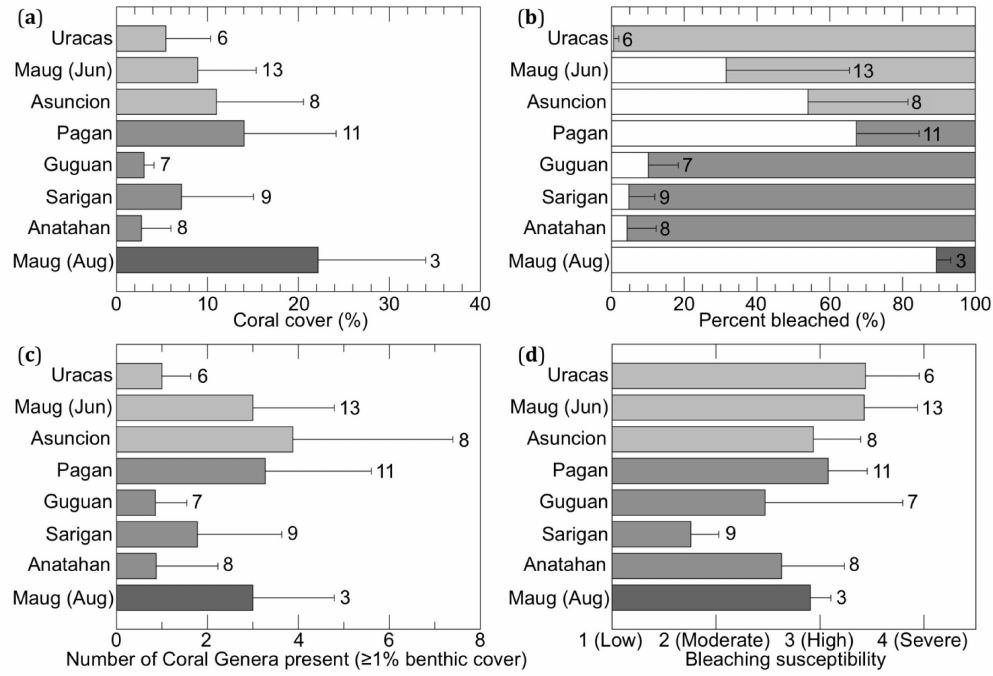
Figure 3. Observed ( a ) coral cover; ( b ) percent of coral bleached (white shading); and ( c ) number of coral genera present; with calculated ( d ) bleaching susceptibility, compiled by island and survey month. Bars show the island-and-month average, while whiskers show 1 SD. Numbers of sites for each island/month grouping are shown. Grey shading in all panels indicates the survey month (light-dark: June–August); white shading in ( b ) indicates percent bleached. Note that Maug was surveyed twice (in June and August 2014).